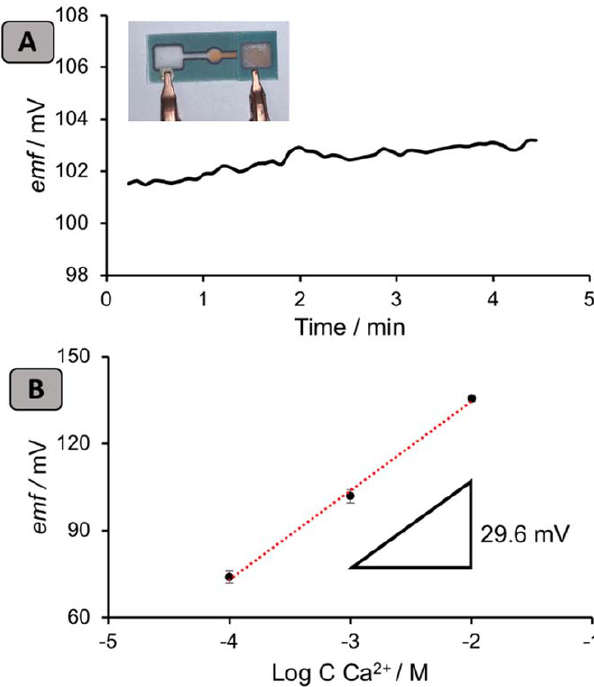
Figure 6. (A). An emf trace of a Ca 2 + paper-based device across 4 min with an average drift of 369 μ V min − 1 . (B). A linear calibration of Ca 2 + paper devices with Nernstian response of 29 ± 1 mV Decade − 1 across a range of 10 mM to 100 μ M Ca 2 + at pH 7.4. Deviations were calculated across 3 separate devices at each concentration.